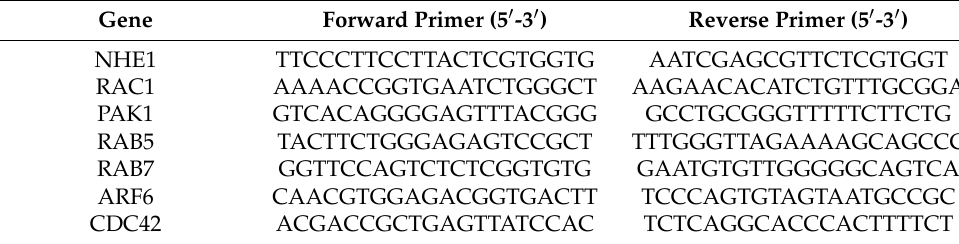
Table 1. Primers used in quantitative real-time